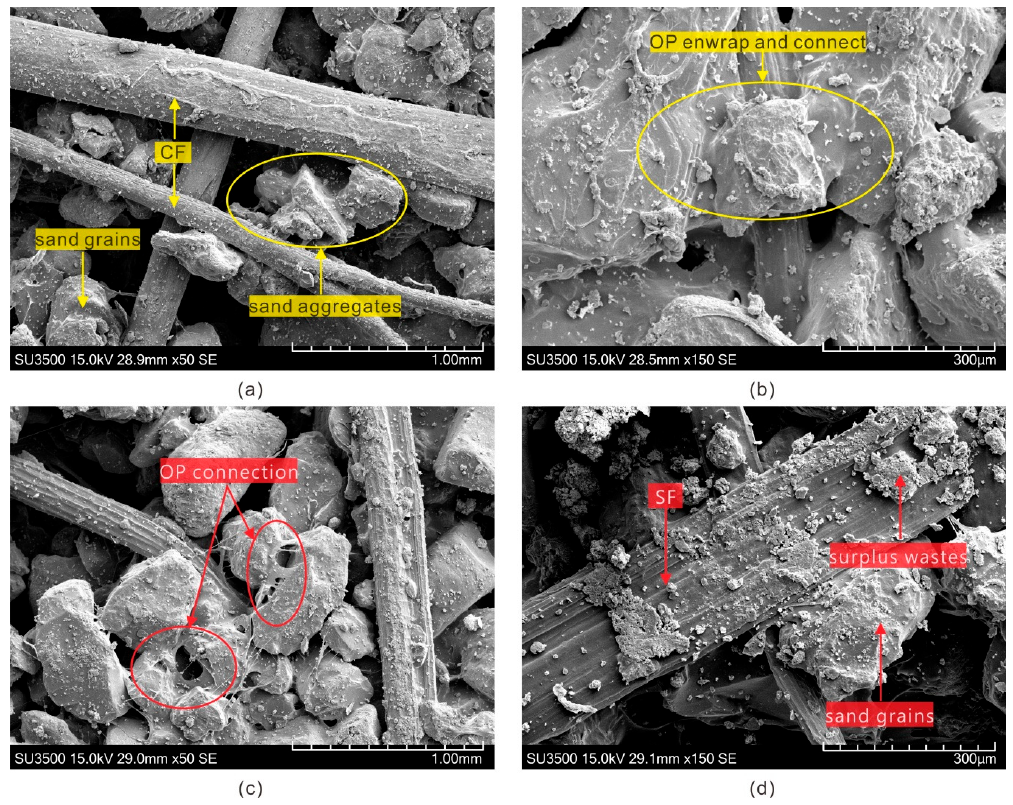
Figure 17. The SEM photographs of ( a ) OPCFRS with 50 magnification, ( b ) OPCFRS with 150 magnification, ( c ) OPSFRS with 50 magnification, and ( d ) OPCFRS with 150 magnification. magnification, ( c ) OPSFRS with 50 magnification, and ( d ) OPCFRS with 150